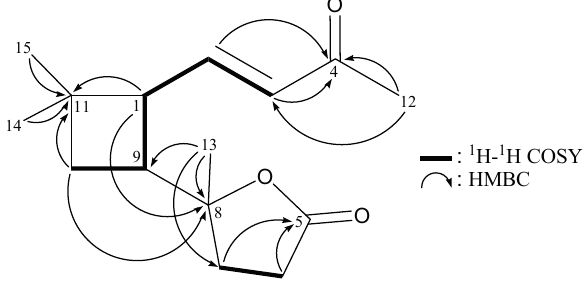
Figure 1. Selective key 1 H- 1 H COSY and HMBC correlations for 1 .